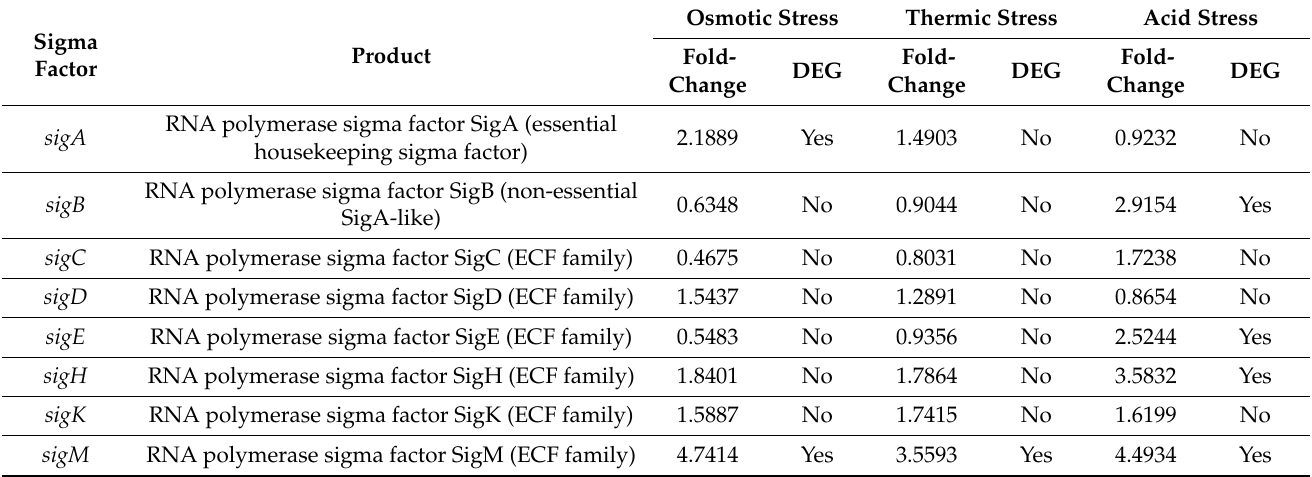
RNA polymerase sigma factor SigM (ECF